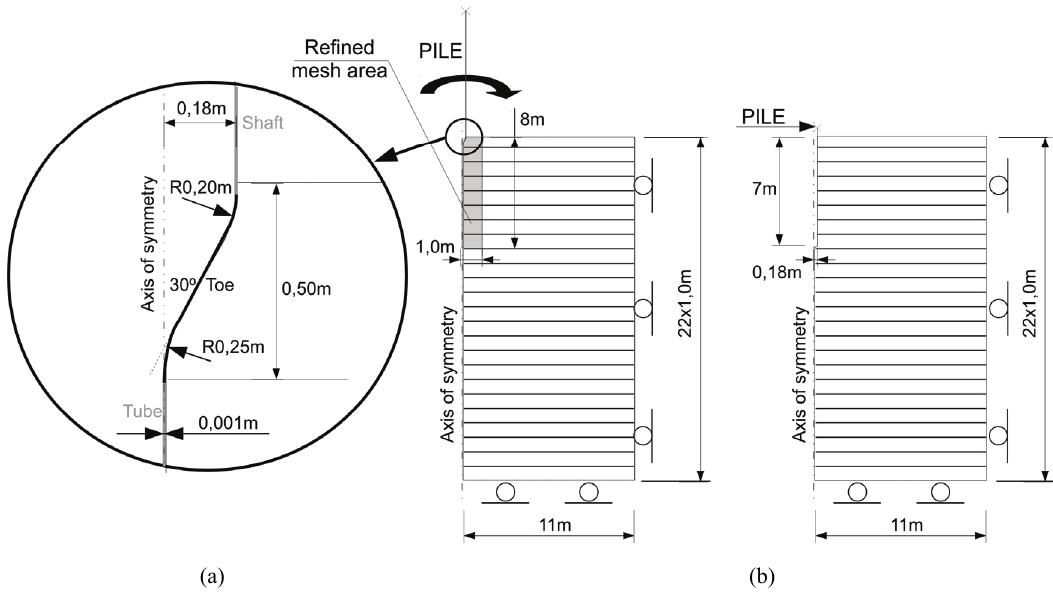
Fig. 5. Geometry of (a) CMC-1 (”set-up” pile) and (b) CMC-2 (“wish-in-place” pile) models